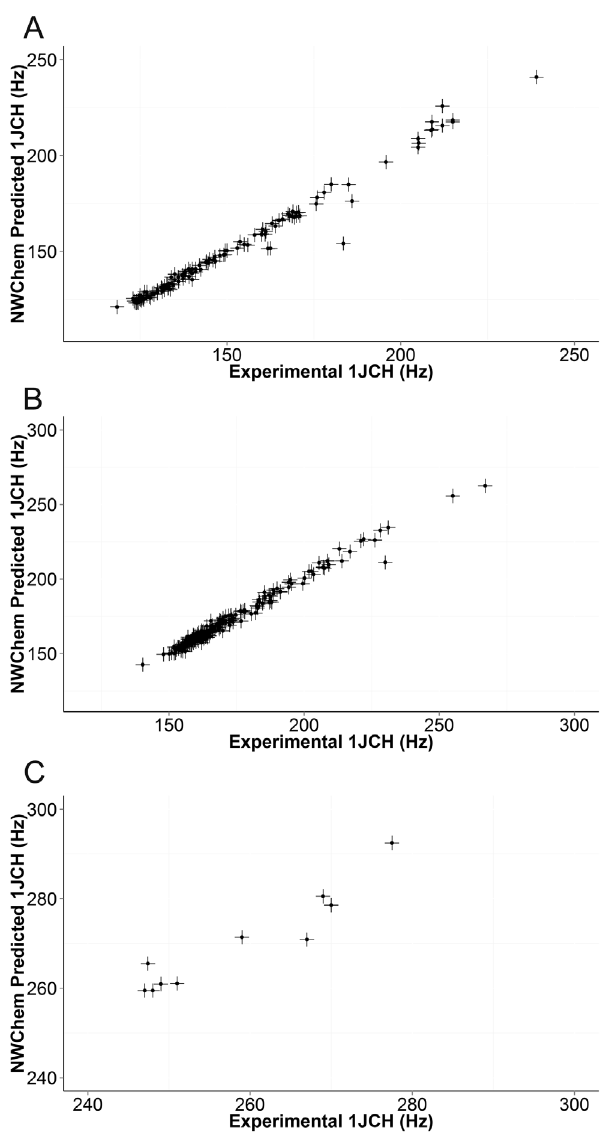
Figure 3. Plots of the observed and predicted 1 J CH for different hybridization states. A: sp 3 pairs. B: sp 2 pairs. C: sp pairs.